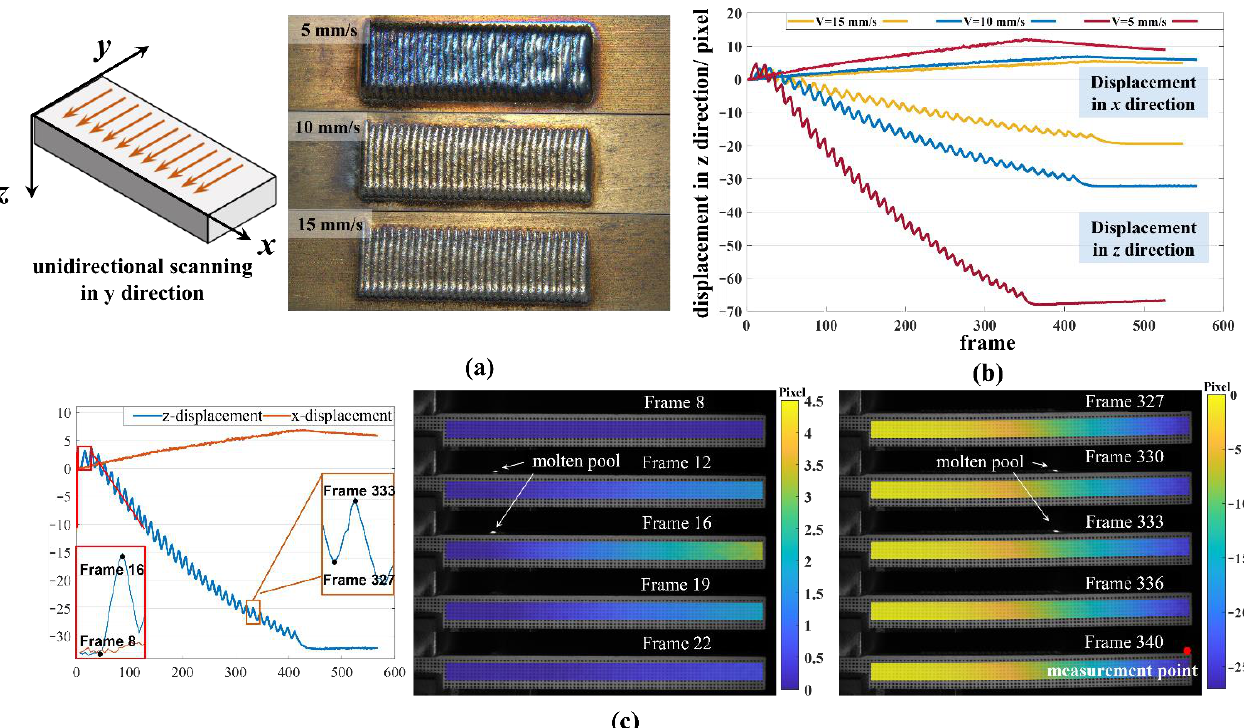
Figure 11. ( a ) Cladding results at different scanning speeds, ( b ) displacement evolution at different scanning speeds and ( c ) z -direction displacement field in a single cycle at 10 mm/s.